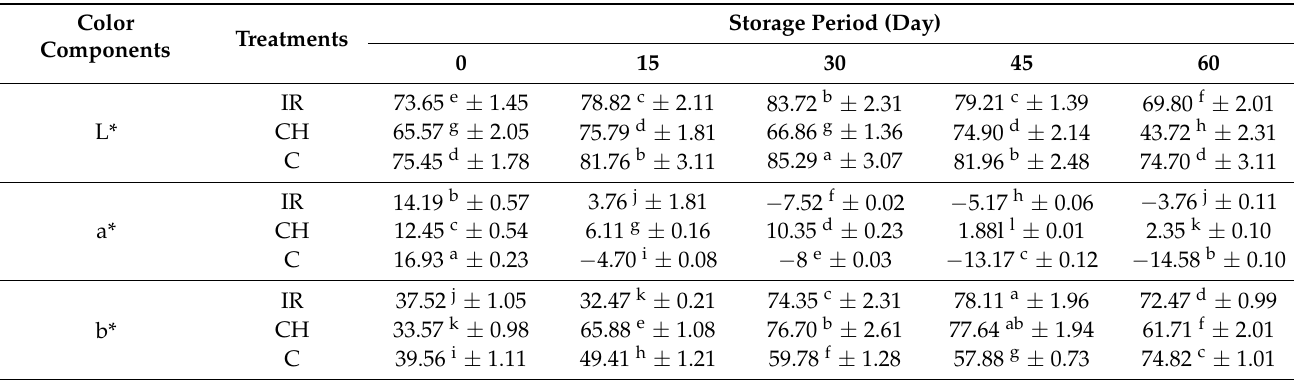
Table 1. The effect of storage periods on the color components of treated key lime juice using infrared, conventional heating compared to fresh (control